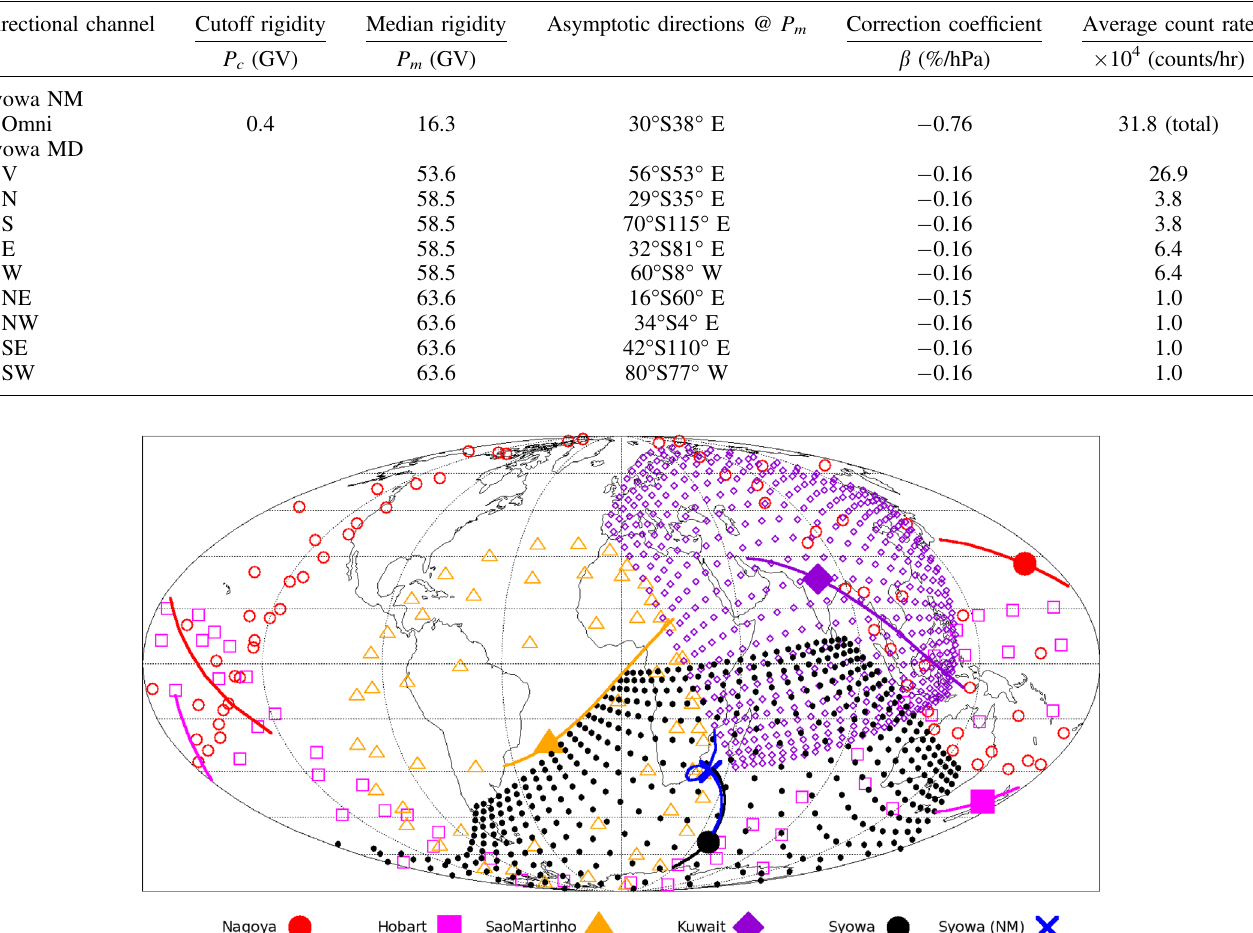
Fig. 5. (a) Schematic view of 4-fold coincidence of MD. (b) Combined 9 directional channels for better statistics. These channels are equivalent to those available from 3 (cid:2) 3 arrays of 50 cm (cid:2) 50 cm square detectors on the upper and lower layers. Table 1. Characteristics of Syowa NM and MD. P c of NM is calculated for vertical